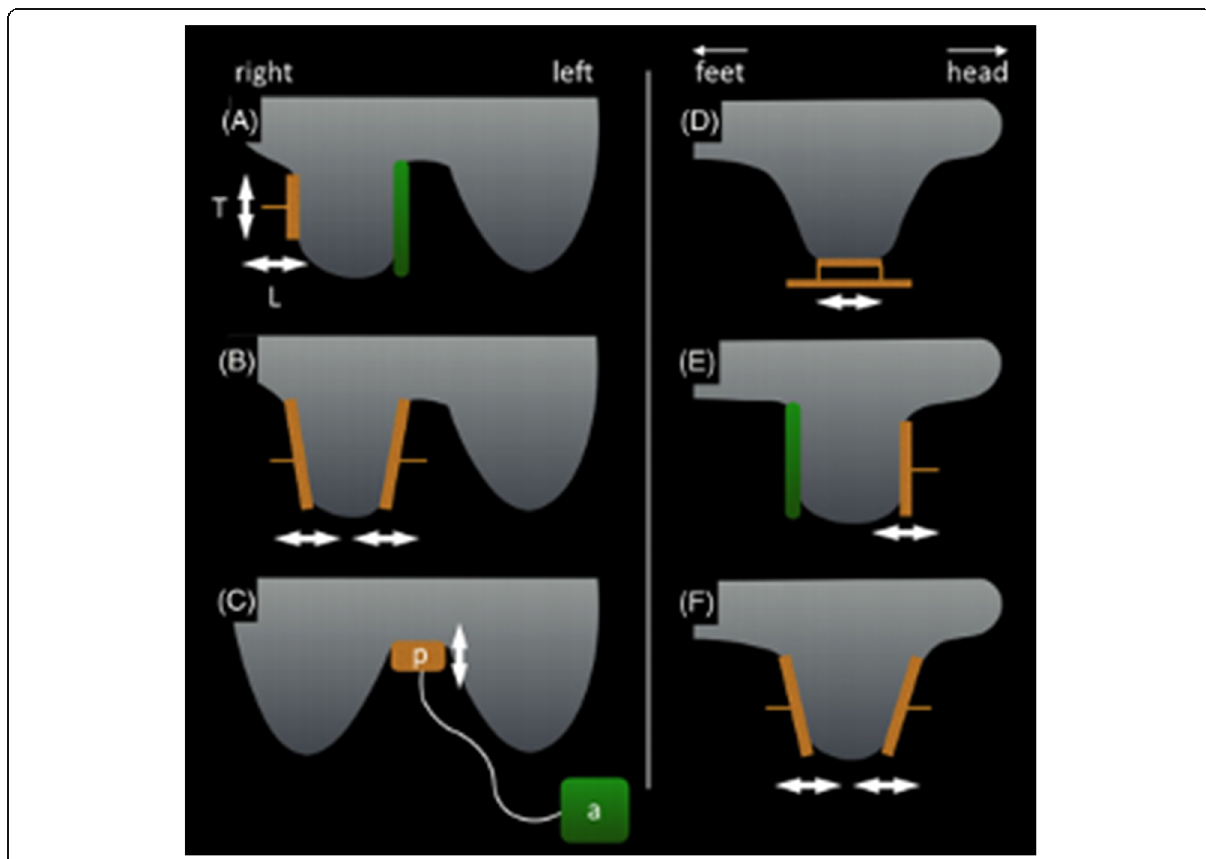
Fig. 14 Simulation map of transmission methods of mechanical waves to the breast tissue. The coil around it is not drawn. a The breast is positioned against a stationary plate in the inner part and mechanical waves are introduced from the outer portion in the longitudinal direction L or transverse T. b Two mechanical wave transmitters are positioned obliquely on the inner and outer sides of the breast. c Mechanical waves are transmitted to the sternum by an unknown transmitter. d A shear plate is placed in front of the breast. e The breast is fixed at the bottom of the plate and mechanical waves are introduced from the top of the breast. f Two mechanical wave transmitters are positioned obliquely in the upper and lower part of the breast that simultaneously produces mechanical waves [36]